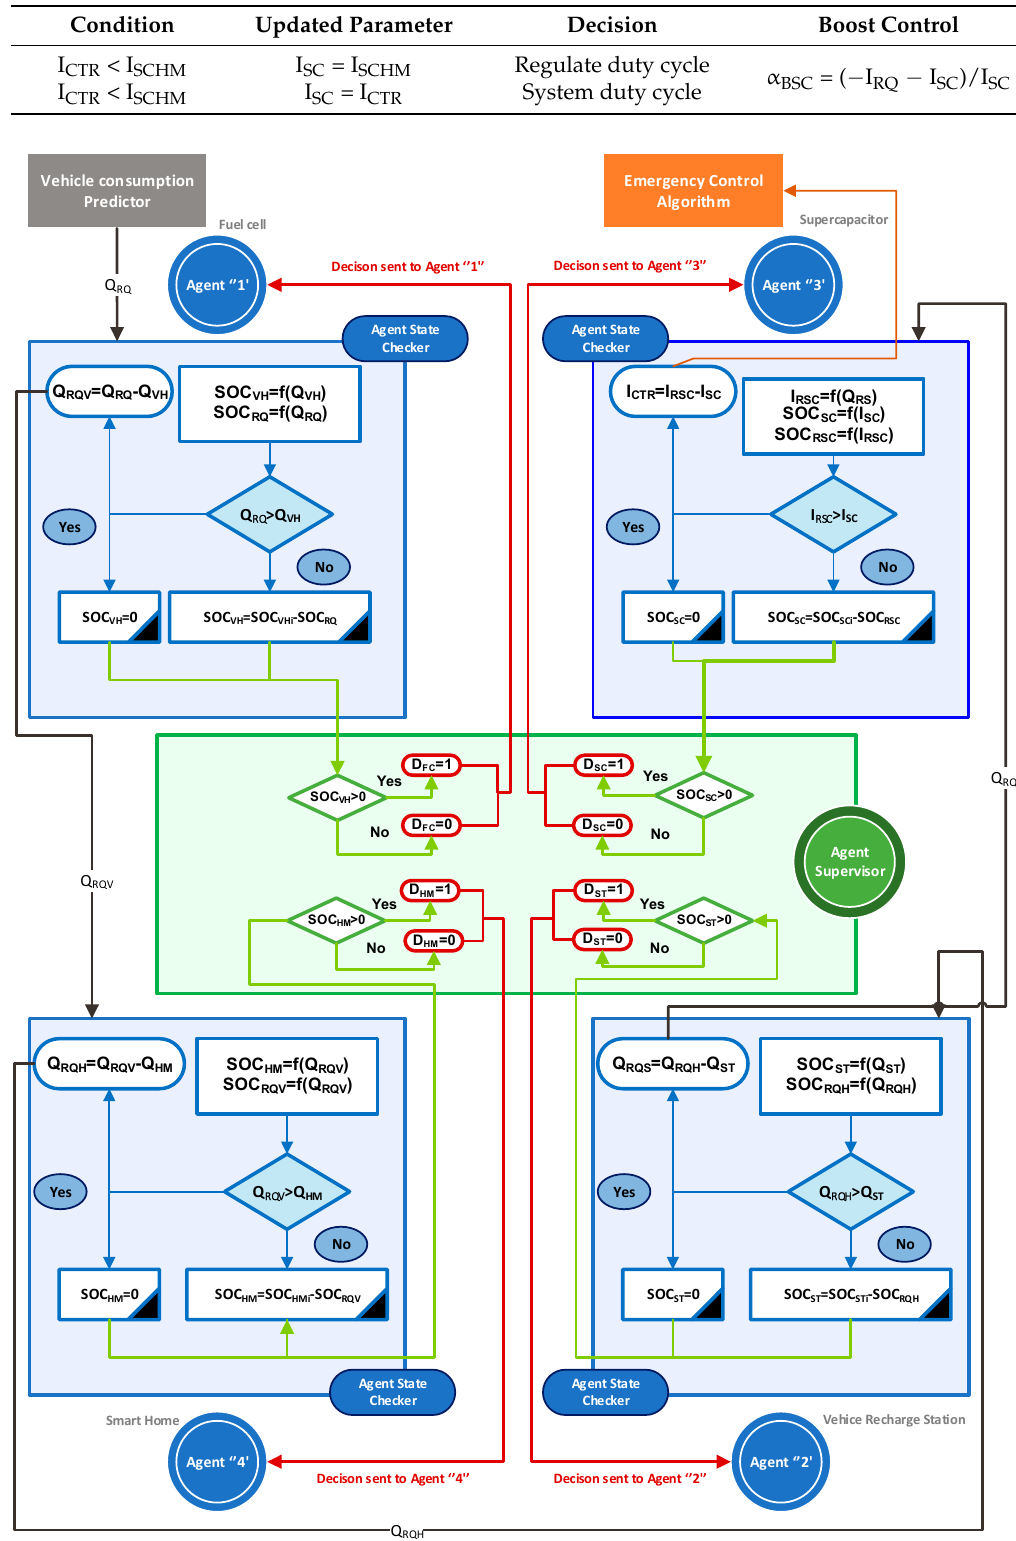
Figure 5. Agent communication control algorithm.